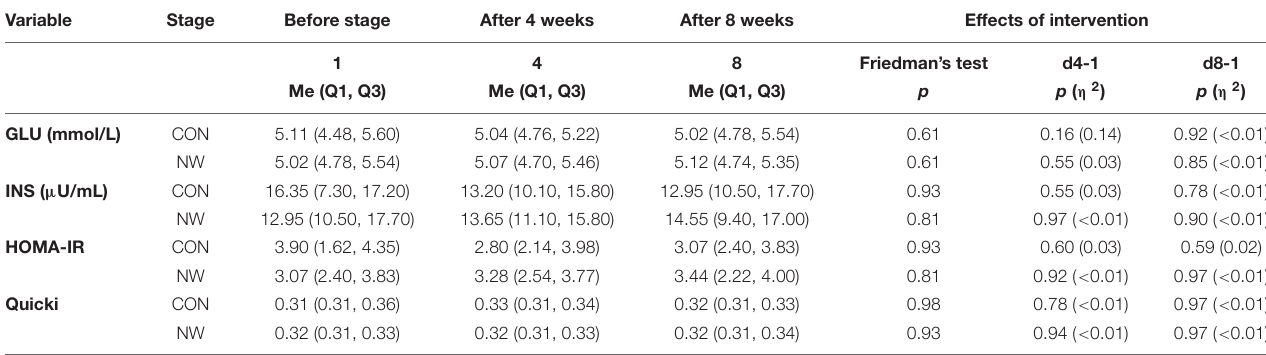
TABLE 4 | Blood glucose and insulin levels as well as level of insulin resistance indices during the control (CON) and Nordic walking (NW) stages. Variable Stage